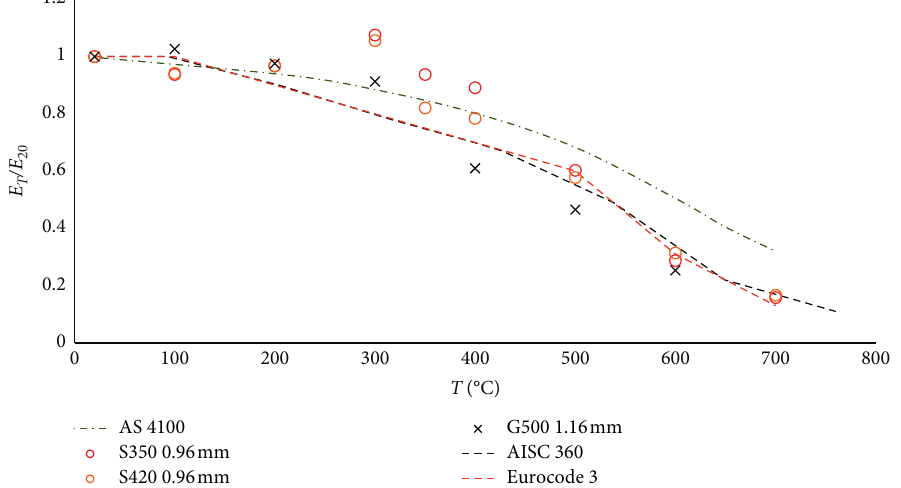
Figure 16: Comparison of the retention factors of elastic modulus according to test results with the current design codes.